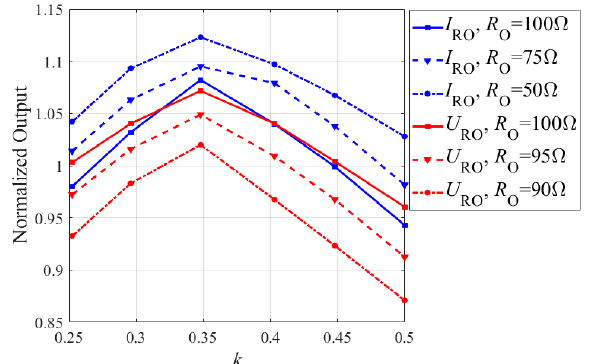
Figure 11. Normalized output currents and voltages of the LCC-S compensation topology designed by the new method.